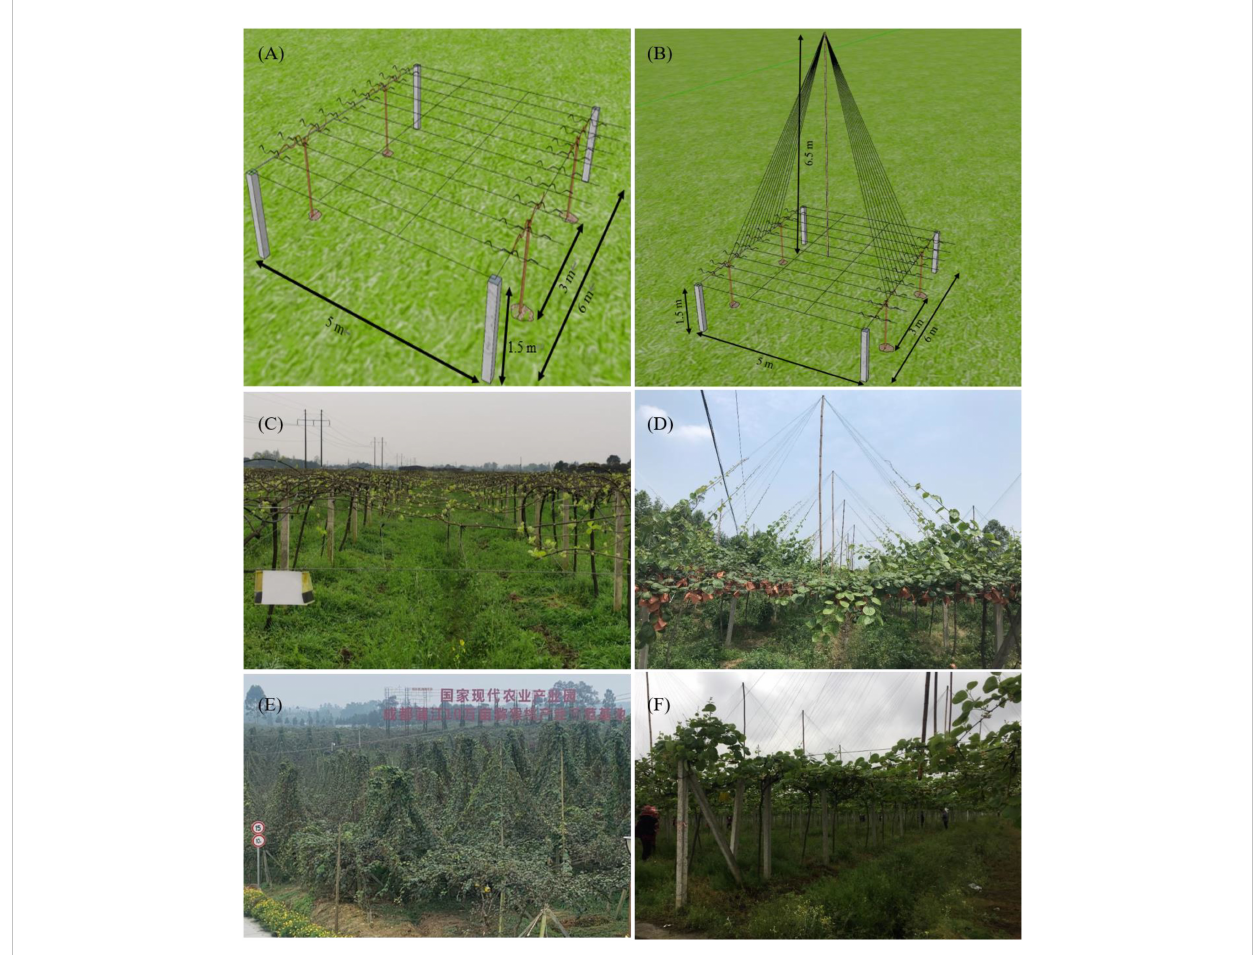
FIGURE 1 Schematic representations and fi eld phenotypic characteristics of the traditional overhead pergolas trellis (OPT) and umbrella-shaped trellis (UST). (A) Schematic diagram illustrating the cane con fi guration (tree architecture) of the OPT, (B) schematic diagram illustrating cane con fi guration (tree architecture) of the UST, (C) fi eld performance of the OPT, and (D – F) fi eld performances of the